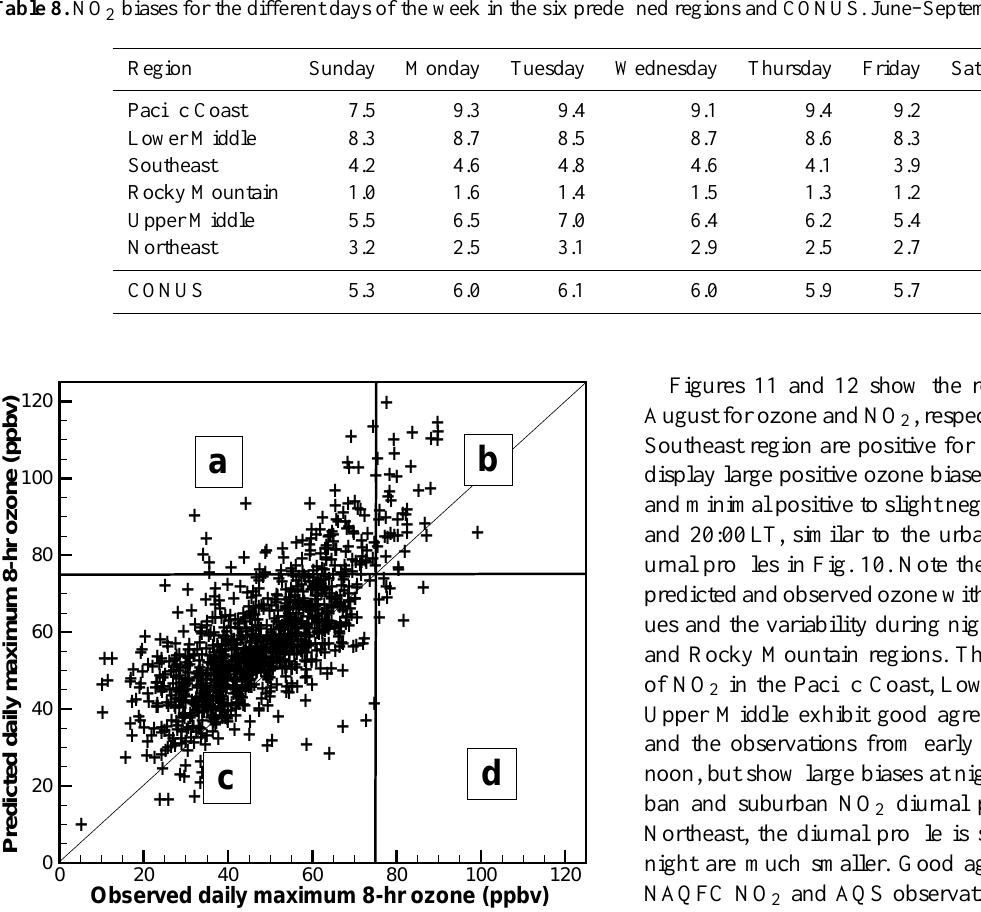
Fig. 9. Diagram of categorical statistics calculation. A scatter plot with AQS observed and NAQFC predicted daily maximum eight- hour average ozone on 17 August 2010 is shown as an example. The US standard for daily maximum eight-hour average ozone of 75ppbv is used as the threshold to delimit the scatter plots into four regions, (a) prediction is above, but observation is below the thresh- old; (b) prediction and observation are above the threshold; (c) pre- diction and observation are below the threshold; (d) prediction is below, but observation is above the